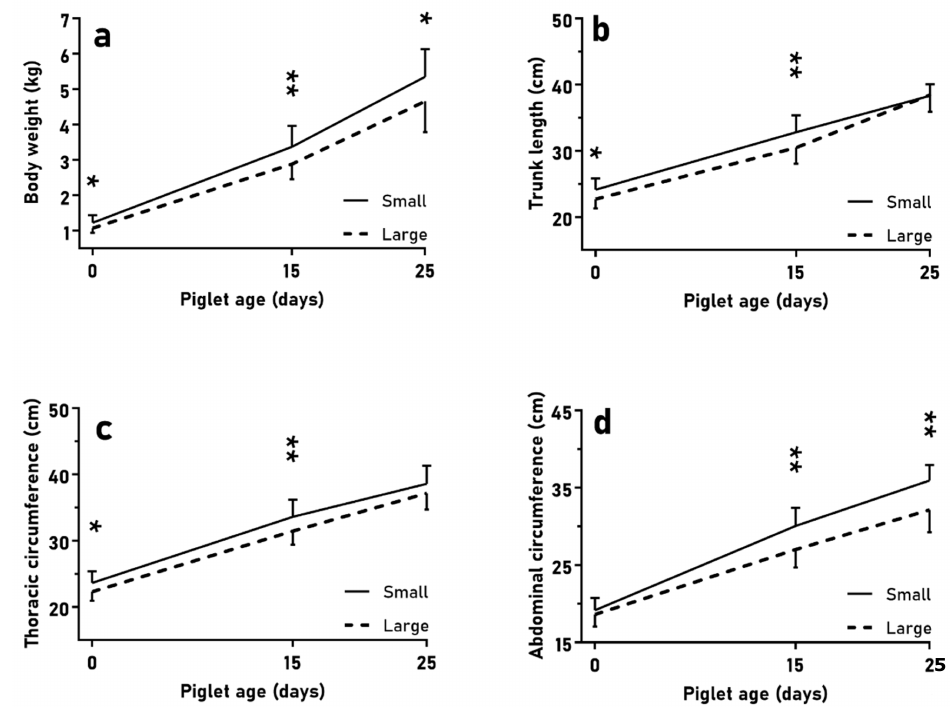
Figure 1. Mean values ( ± SD) of body weight ( a ), trunk length ( b ), and thoracic and abdominal circumferences ( c , d ) over the course of lactation when comparing normal birth-birth (NBW) piglets from small ( n = 24) and large litters ( n = 30). Asterisks indicate significant di ff erences between groups (* p < 0.05, ** p < 0.01).